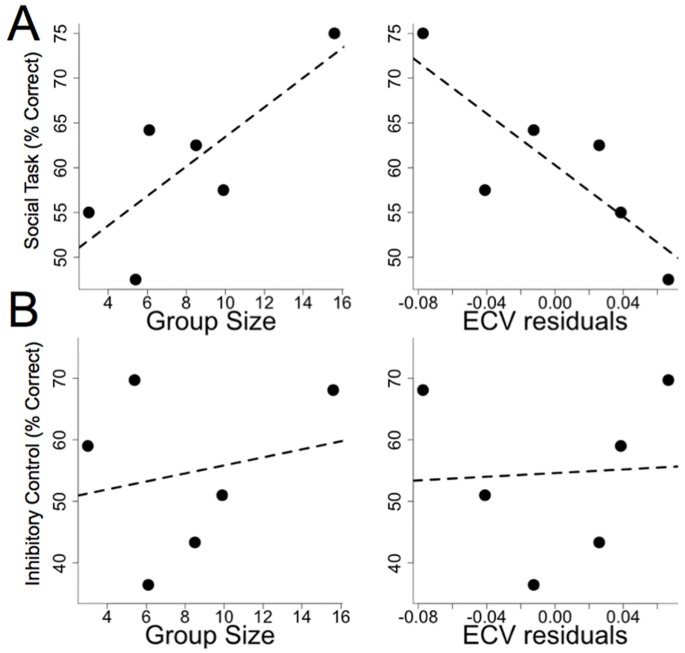
Performance in the cognitive tasks as a function of social group size and residual endocranial volume (ECV), a measure of relative brain size.We tested the hypotheses that social group size and relative brain size would predict species performance. A) As predicted by the social intelligence hypothesis, species characterized by larger social groups performed better in the social cognition task. Relative brain size did not explain species’ performance, and the slope of the relationship was negative. B) Group size did not predict performance on the non-social inhibitory control task. As in the social task, relative brain size was not a predictor of performance on the inhibitory control task.